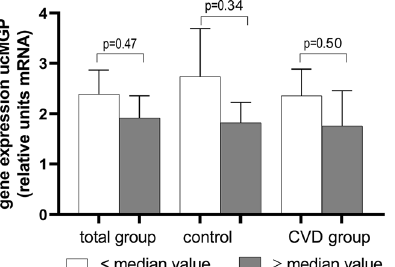
Figure 5: Expression of MGP in PBMC according to circulating ucMGP plasma